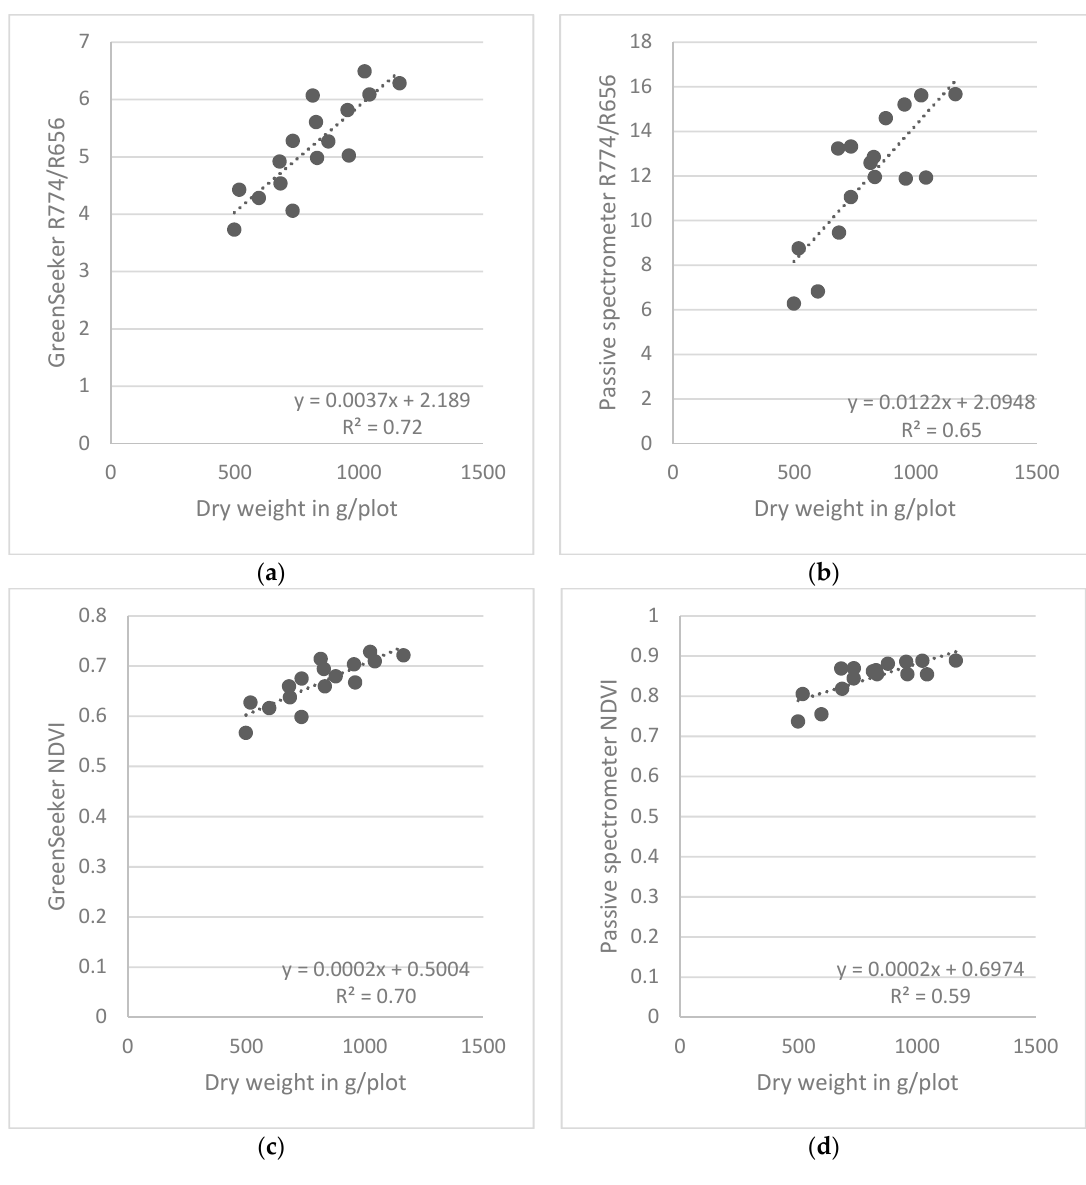
Figure 5. Relationships between spectral indices derived from the two types of sensors and plant dry weight at ZS 65 for wheat, obtained from linear regressions combining the four different row designs.